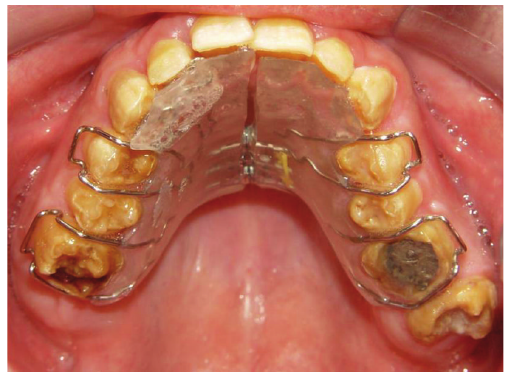
Figure 5: Orthodontic treatment with removable